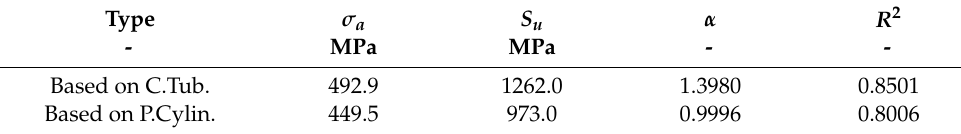
Table 3. Parameters of the Kwofie model for the case-carburized